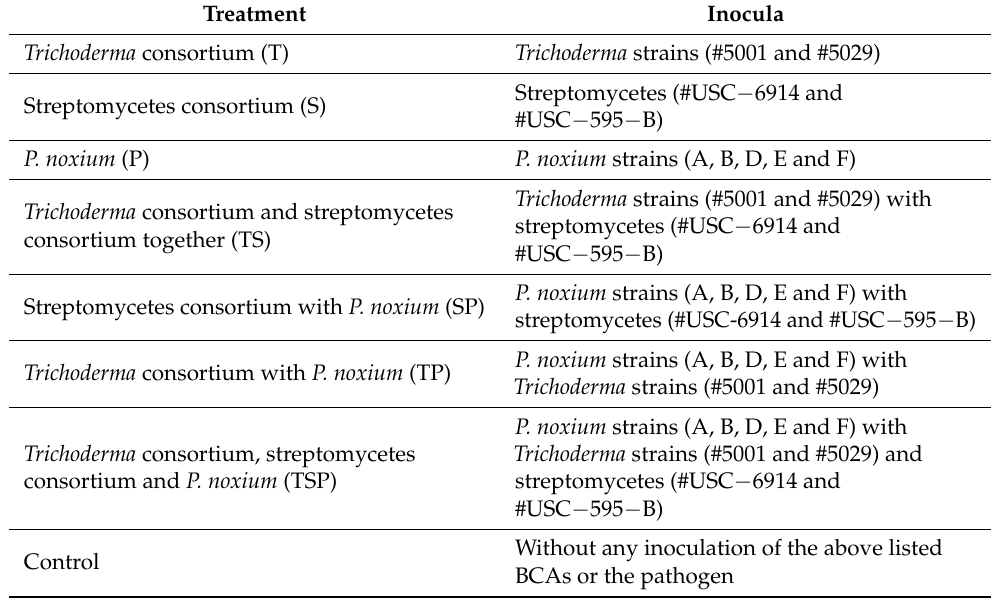
Table 1. Detail of the inocula used in each